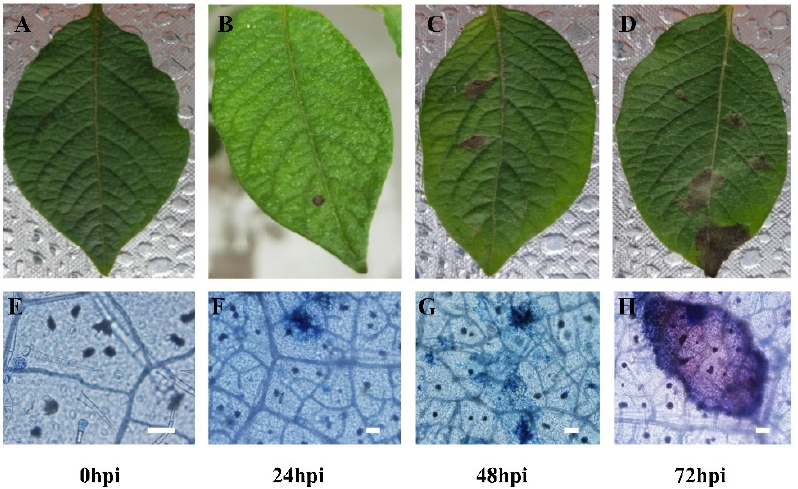
Figure 1. The appropriate time points of Qingshu 9 infected with P. infestans were confirmed by microscopic observation. ( A , E ) At 0 h post-inoculation (hpi), the stomas can be clearly seen and the infection has not yet started (( E ) bar = 20 µ m). ( B , F ) At 24 hpi, sporadic necrotic spots appeared on the leaves, and the necrotic spots were surrounded by hyphae (( F ) bar = 10 µ m). ( C , G ) At 48 hpi, the number of lesions and hyphae gradually increase ( G ) bar = 10 µm). ( D , H ) At 72 hpi, the area and number of lesions have increased significantly (( H ) bar = 10 µm). Table 2. The data quality analysis in the investigated samples.